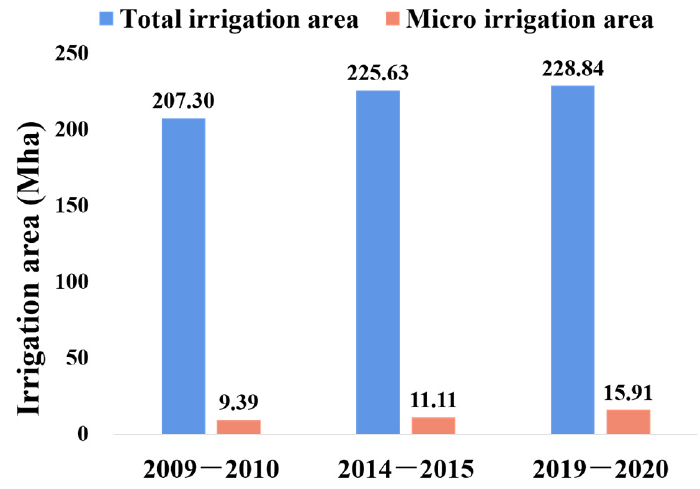
Figure 1. Total irrigation area and micro irrigation area of the globe.